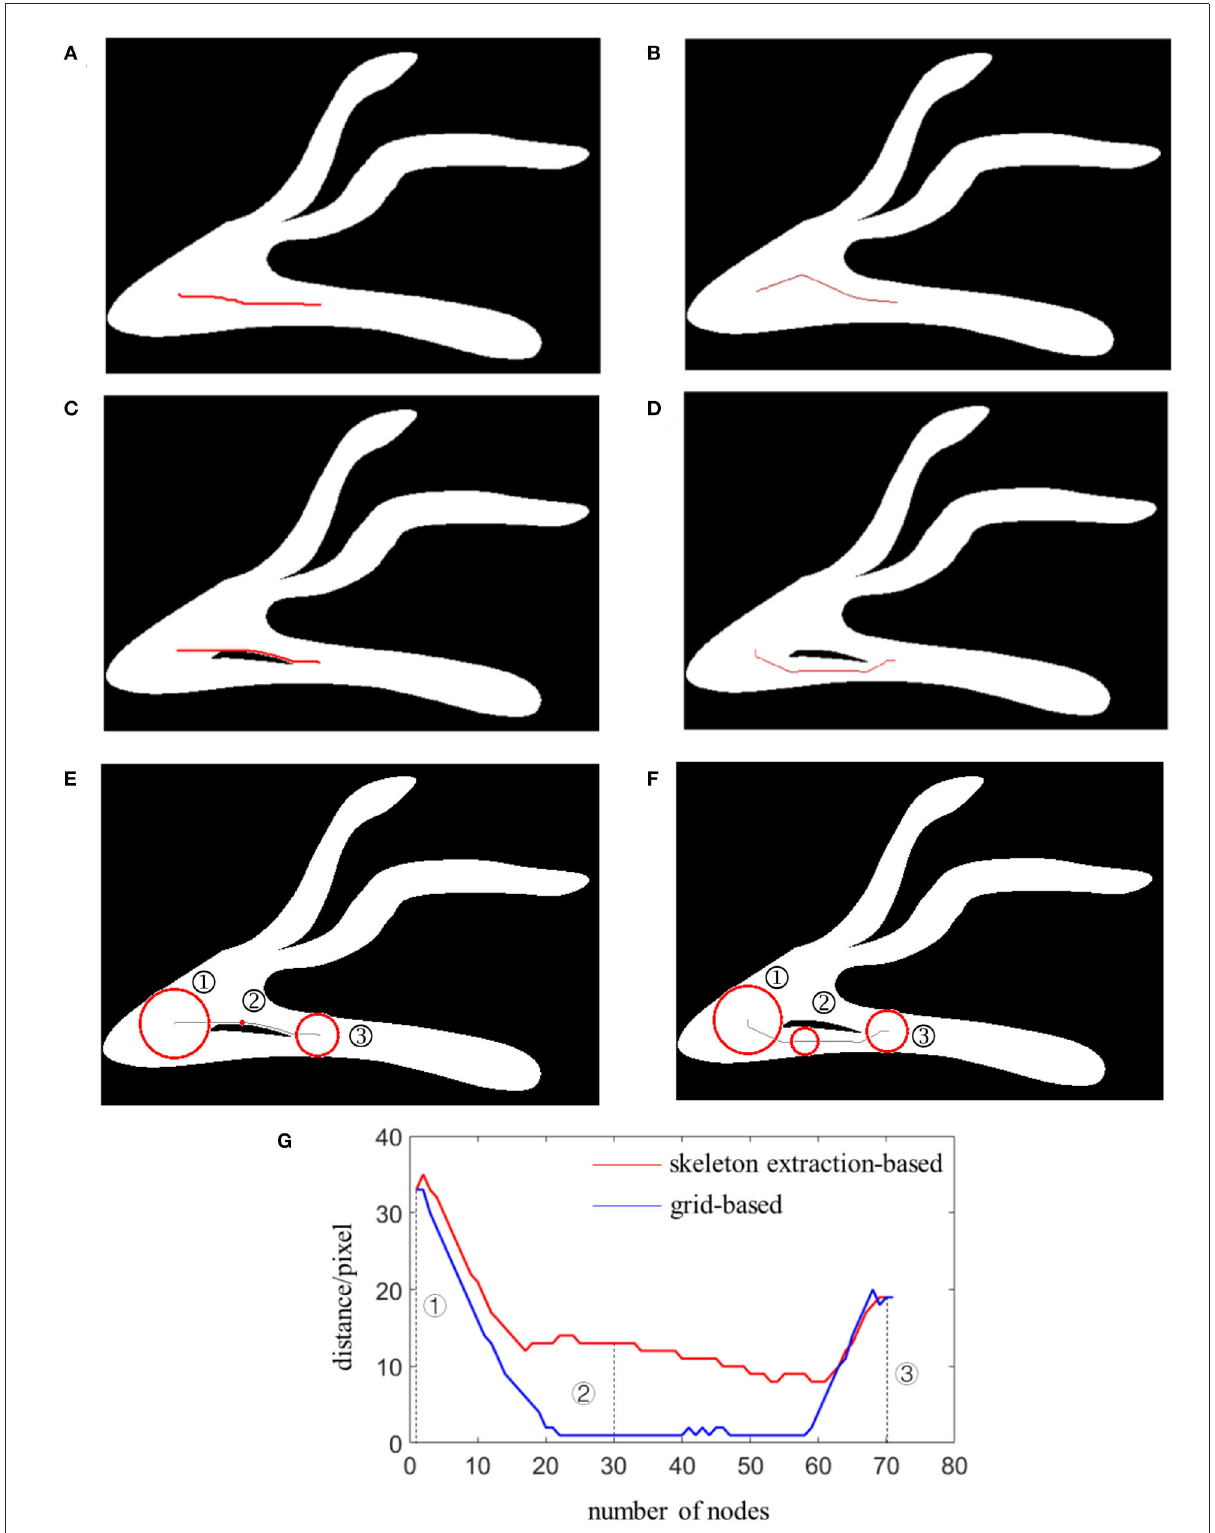
FIGURE2 Path planning in Map 1 with: (A) grid-based A*algorithm; (B) skeleton-extraction-based A*algorithm; path planning in Map 2 with: (C) grid-based A*algorithm; (D) skeleton-extraction-based A*algorithm; distance evaluation for Map 2 planned with (E) grid-based A*algorithm; (F) skeleton-extraction-based A*algorithm; (G) an analysis curve